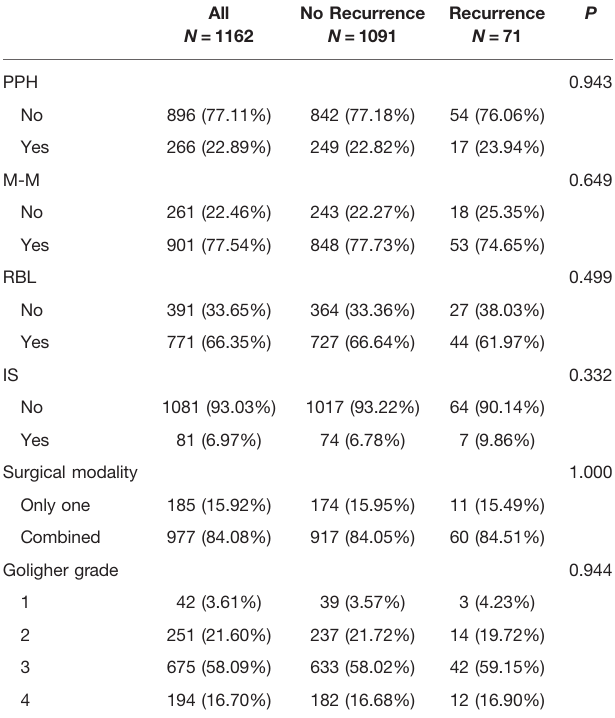
TABLE 5 | Effects of surgical modality and goligher grade on hemorrhoid recurrence rates.